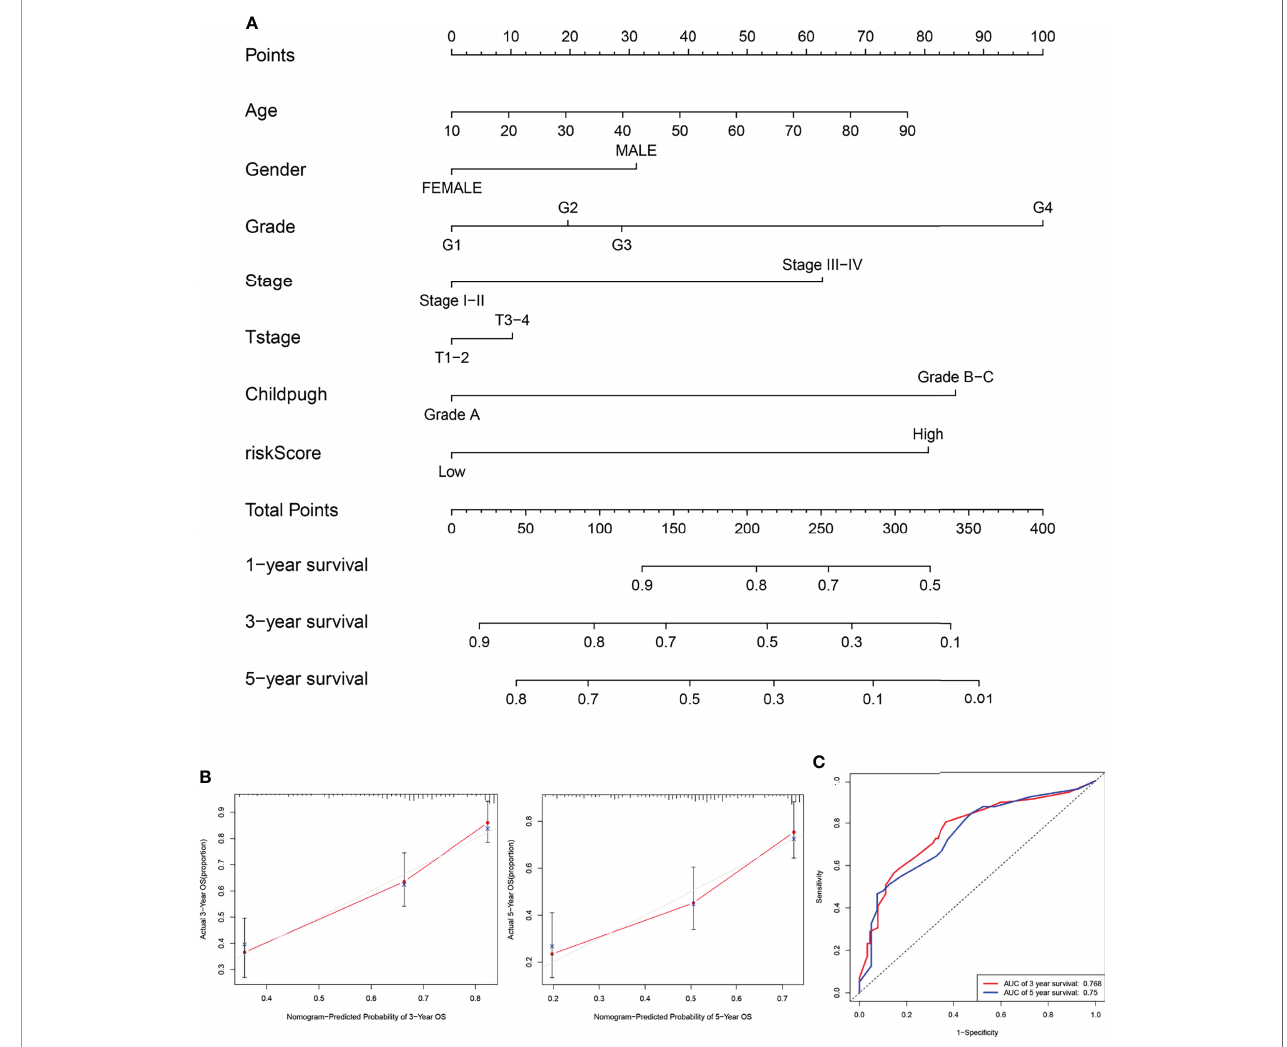
FIGURE 7 | Establishment of the nomogram. (A) The nomogram integrating clinicopathological parameters and the CCS-based risk score for predicting the 3- and 5-year OS of HCC patients. (B) Calibration plots for both 3-year OS and 5-year OS in ideal prediction with actual observations. (C) The ROC curves for evaluating the prognostic performance of the nomogram for 3-year OS and 5-year OS. OS, overall